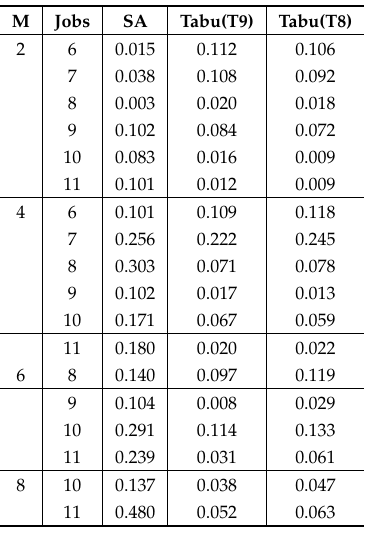
Table 10. The apd values for the small problems for the hybrid method of Simulated Annealing algorithm and Sine Cosine Algorithm (SASCA) and the other